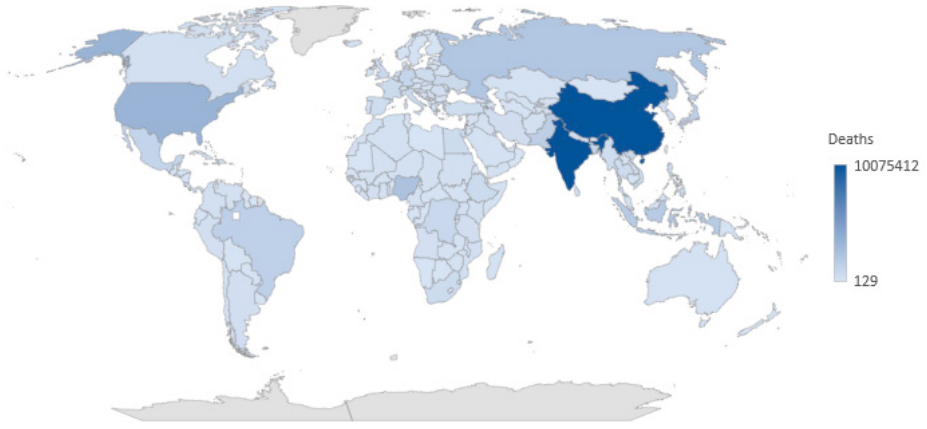
Figure 2. Global comparison of the number of deaths by country. Source: Expansión [7] and the au- thors’ creation.